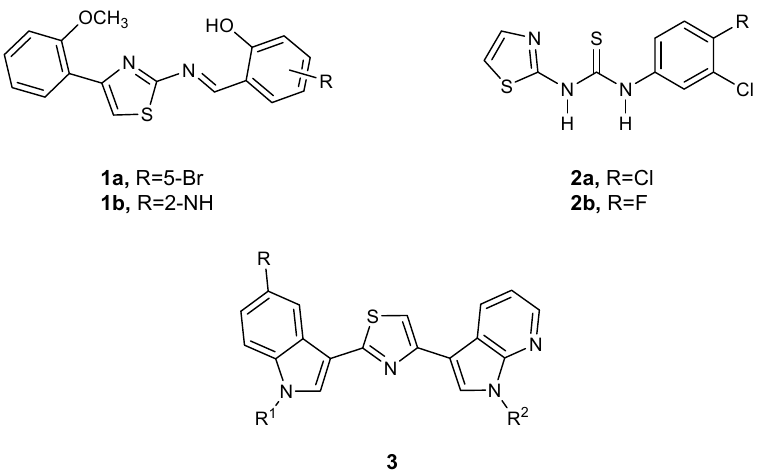
Figure 1. Chemical structures of the thiazole compounds 1a,b ; 2a,b ; and 3 .